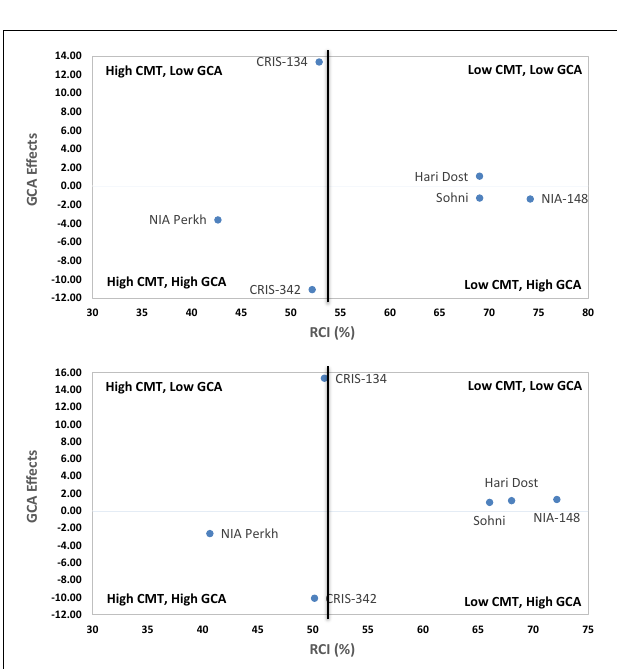
FIGURE 4 | Heat susceptibility index (HSI) for SCY (g/plant) among parents and their progenies in F 1 and F 2 generations.